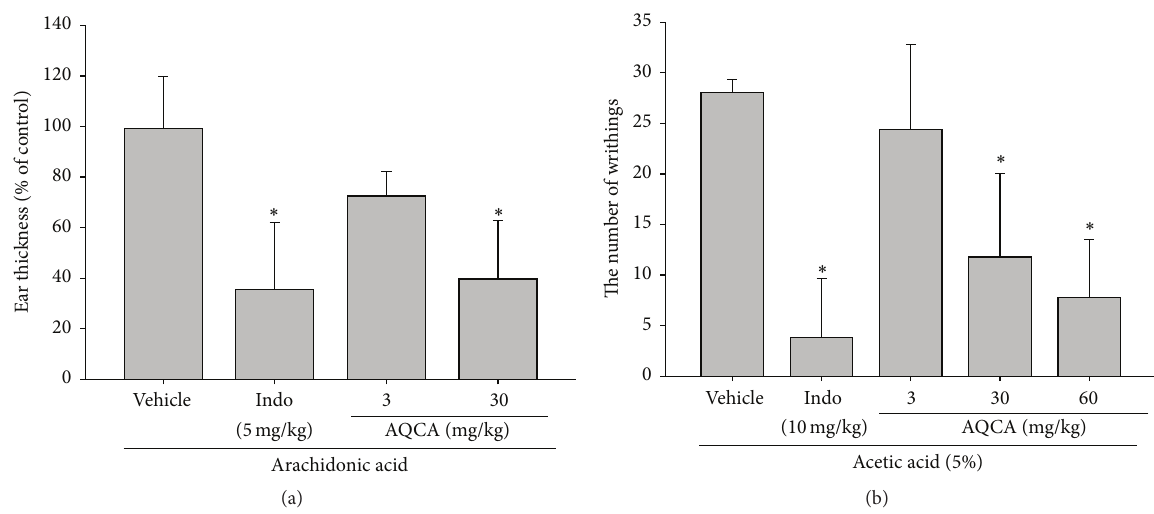
Figure 2: Effect of AQCA on in vivo nociceptive symptoms. (a) Effect of AQCA on arachidonic acid-induced ear edema was evaluated in ICR mice that were treated orally with AQCA (0, 3, and 30 mg/kg) or indomethacin (5mg/kg) for 7 days and with topical application of 2% arachidonic acid solution (25 𝜇 L/ear) to the left ear. The thickness of the edema was measured with a constant-pressure thickness gauge 1h after treatment with arachidonic acid. The ear thickness of mice treated with the inducer alone was considered to be 100%. (b) Effect of AQCA on acetic acid-induced writhing was evaluated in ICR mice that were treated orally with AQCA (0, 3, 30, and 60mg/kg) or indomethacin (10mg/kg) for 3 days and intraperitoneally injected with 5% arachidonic acid solution. The number of writhings was recorded over 20 min and expressed as a percentage relative to the number of writhings in vehicle controls. ∗ 𝑃 < 0.05 compared with the control